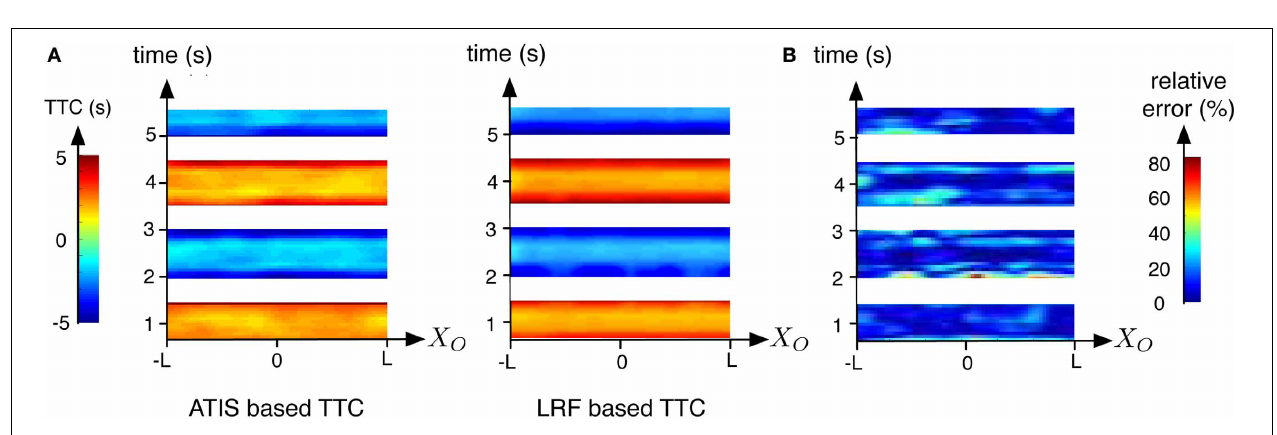
FIGURE 8 | Comparison of the results obtained while the robot is moving forward and backward in the direction of an obstacle. Results are expressed related to time and the coordinates system of the obstacle.